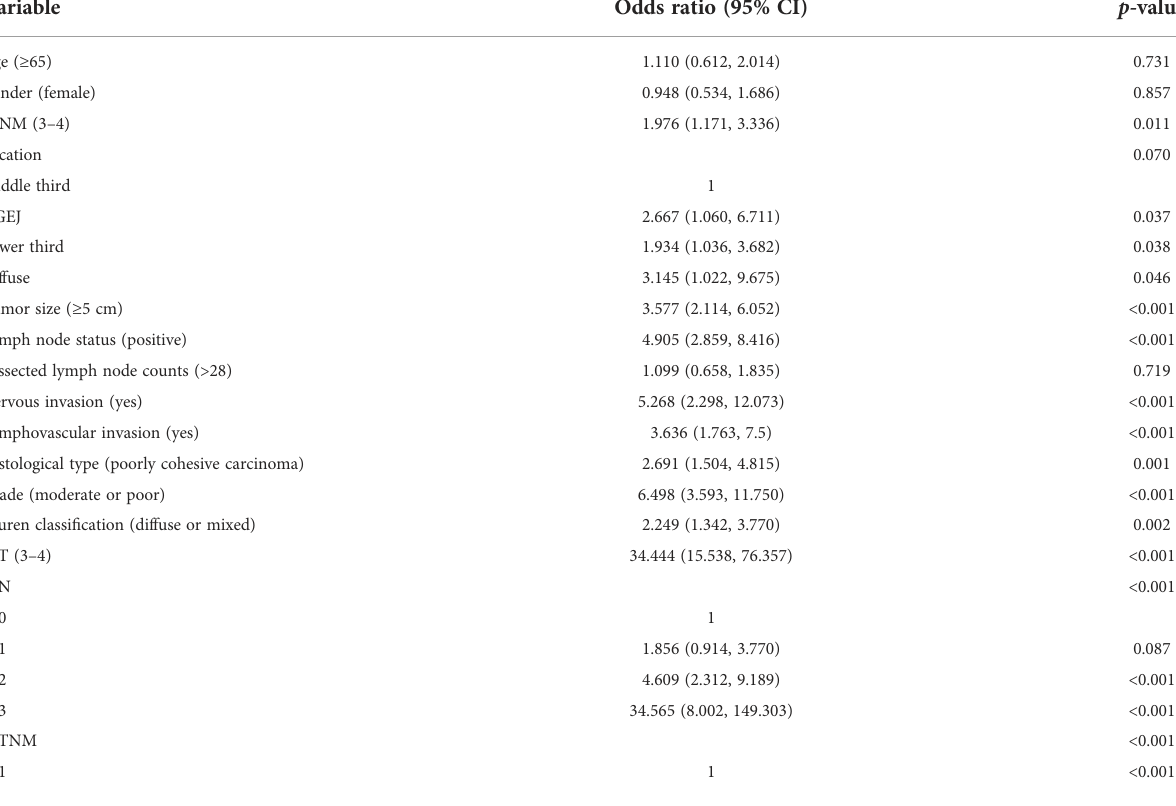
TABLE 3 Univariate analysis of